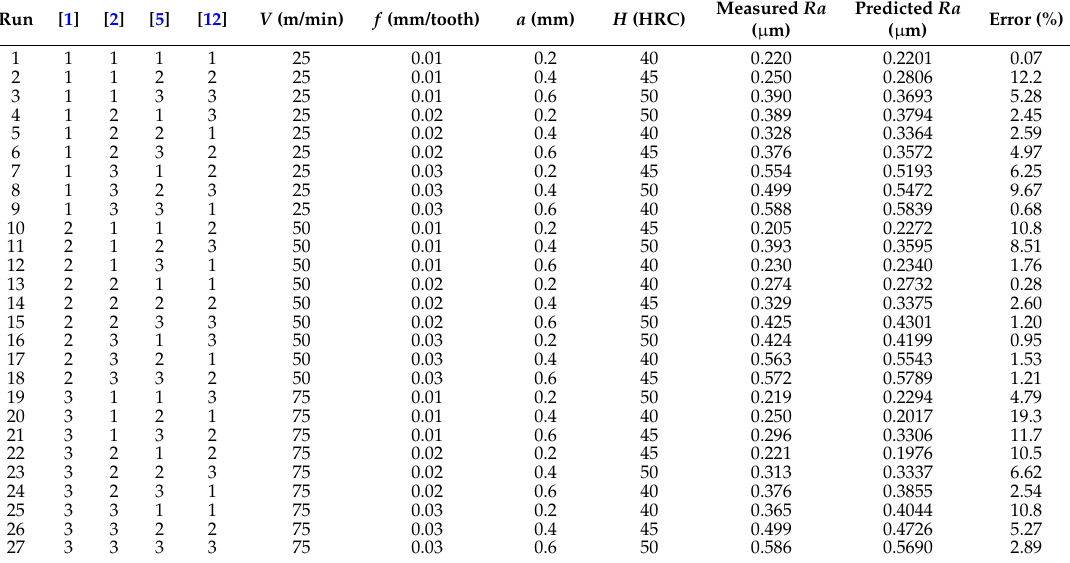
Table 4. Experimental